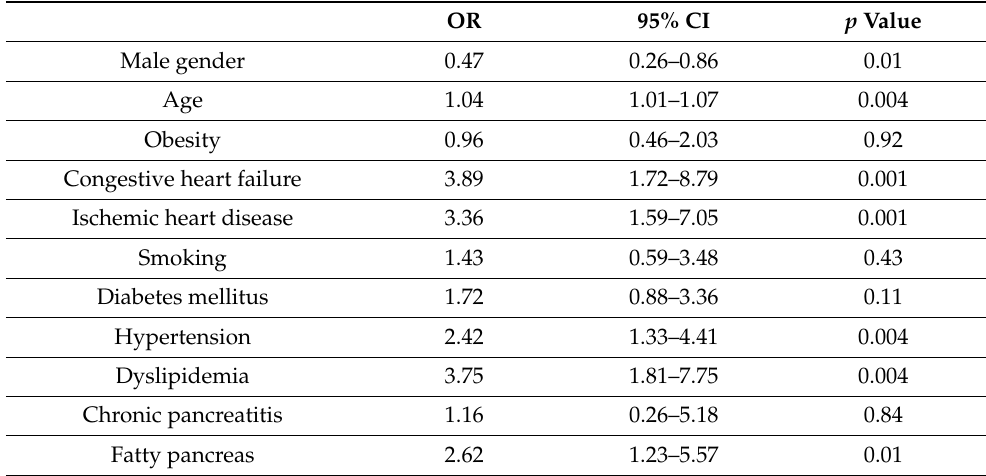
Table 2. Univariate analysis of parameters associated with PC.